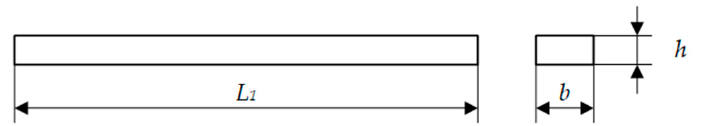
Figure A1. Geometry of the ceramic samples. Table A1. The average geometry parameters of the ceramic samples.